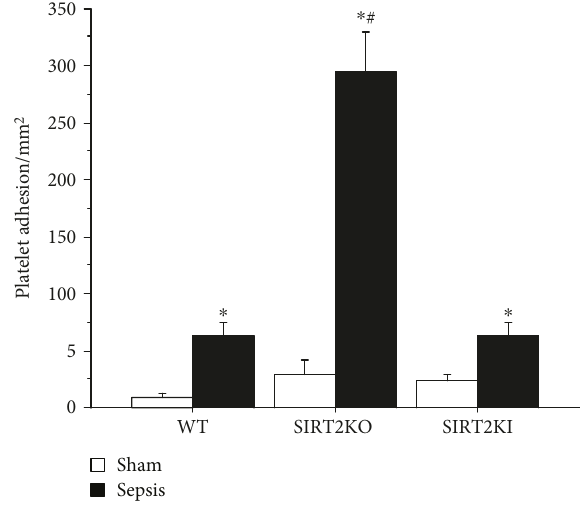
Figure 2: Platelet adhesion with SIRT2 modi fi cation. Platelet adhesion in the small intestinal microcirculation in sepsis groups was signi fi cantly increased versus that in the respective sham groups ( n = 4 – 6 in each group). Platelet adhesion in SIRT2KO sepsis mice was not signi fi cantly increased versus that in WT sepsis; platelet adhesion in SIRT2KI sepsis mice was not signi fi cantly di ff erent versus that in WT sepsis mice. Platelet adhesion in SIRT2KI sepsis mice was signi fi cantly decreased versus that in SIRT2KO sepsis mice. Platelet adhesion in WT, SIRT2KO, and SIRT2KI sham mice were not signi fi cantly di ff erent from each other. ∗ p < 0 05 versus respective sham; # p < 0 05 versus WT sepsis using Tukey ’ s post hoc analysis; error bars: sem.